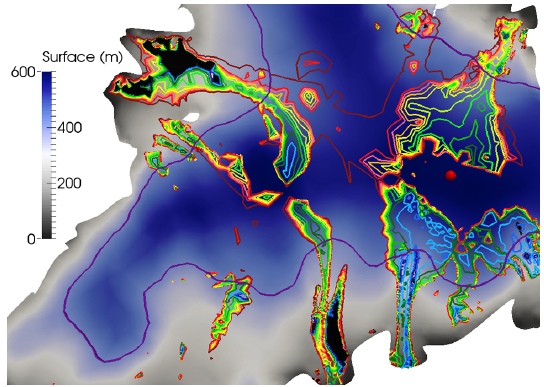
Figure 15. Temporal evolution of the temperature field during a simplified transient simulation from 1995ss towards the steady-state firnss with the friction parameter beta95T . The firn line is shown in violet, the drill hole corresponds to the red dot. The evolution of the “sliding area” (271K) from 1995ss to firnss is shown in rainbow colours (black area; blue, green, yellow, red contour lines) 100years apart (dark green for example corresponds to 500years). As texture the surface elevation is